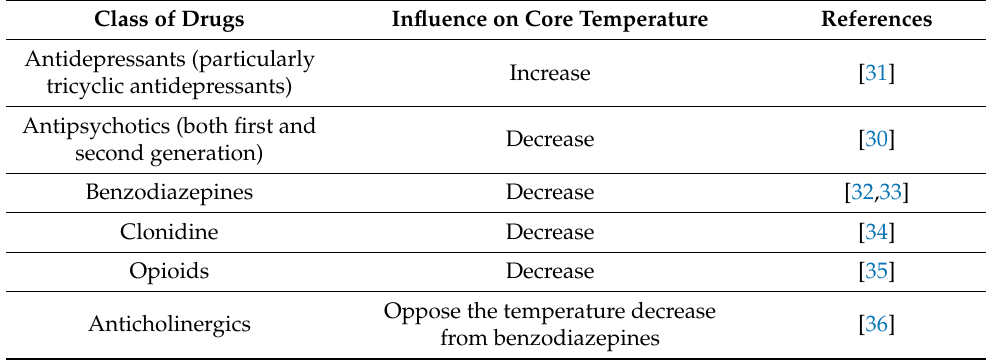
Table 1. Overview of common preoperative medications and their influence on core